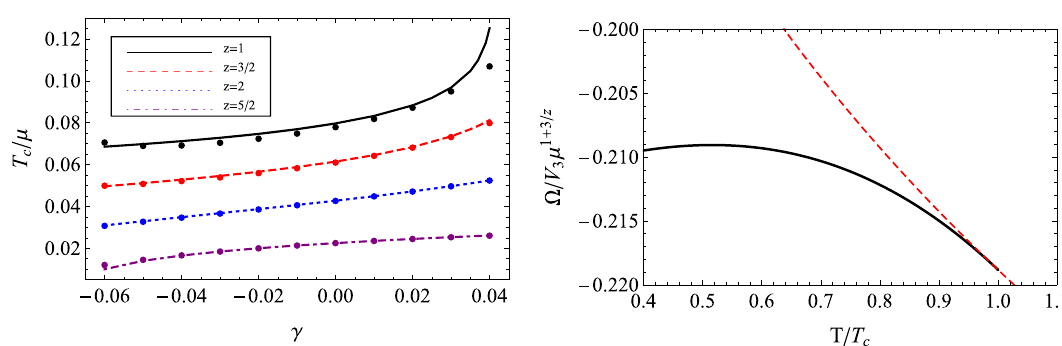
Fig. 2 The condensate versus the temperature with z = 1 (black solid), z = 3 γ = − 6 (the left panel) and γ = 4 100